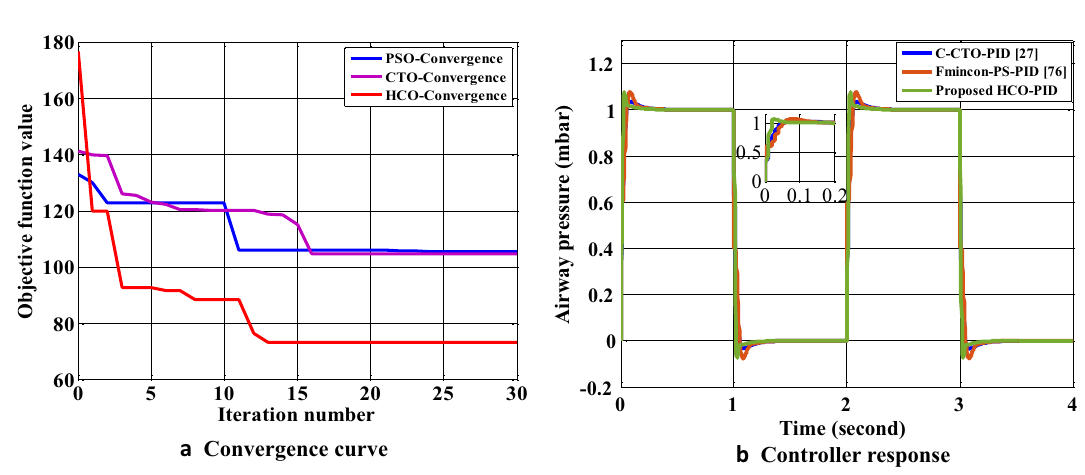
Figure 8. Performance of HCO for PID controller design for ventilator system: ( a ) Convergence graph. ( b ) Response of HCO-PID controller for ventilator